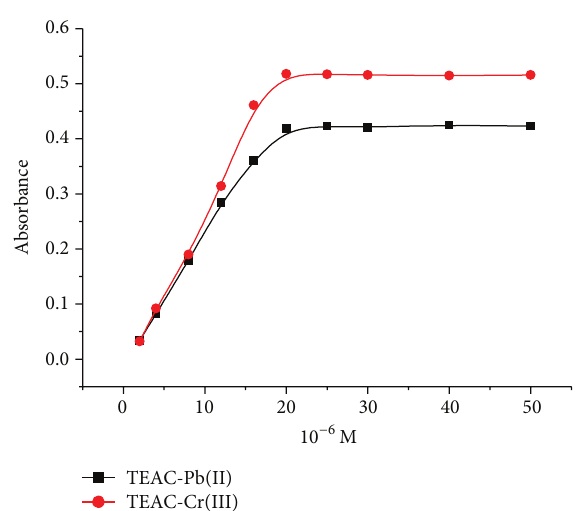
Figure 7: Effect of TEAC reagent concentration on the change in the absorbance of TEAC-Pb(II) and TEAC-Cr(III)